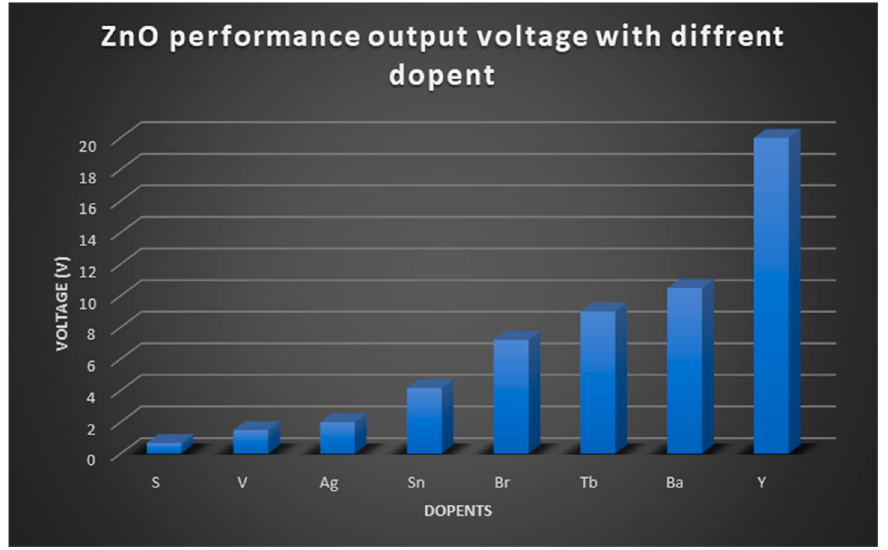
Figure 6. The output voltage of ZnO-based PENG with different dopants [5,76,86–89,91]. (II)